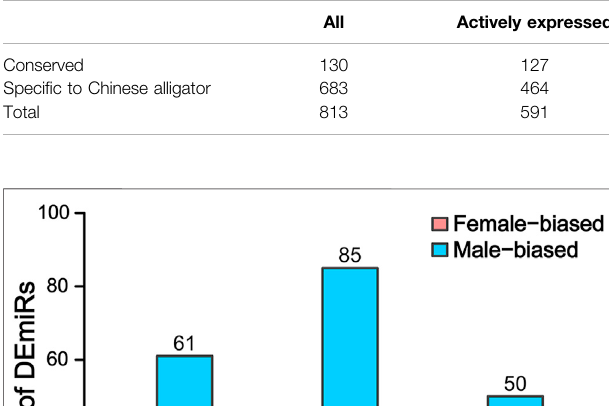
TABLE 1 | MicroRNAs identi fi ed using sRNA sequencing of Chinese alligator gonads.